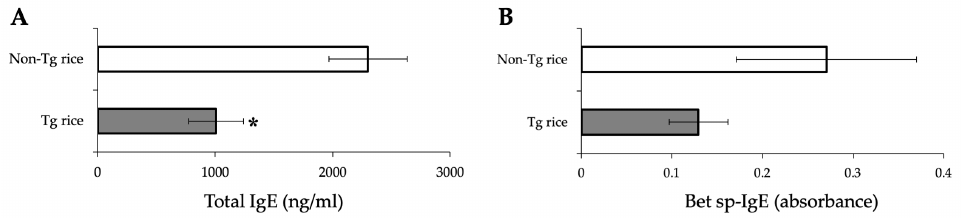
Figure 3. Serum concentration of total IgE ( a ) and Bet v 1-specific IgE ( b ) in mice fed Tg or non-Tg rice. Data are presented as ng/mL or absorbance units. * p < 0.05, Tg vs. non-Tg rice-fed group according to the unpaired Student’s t test (three mice per group).